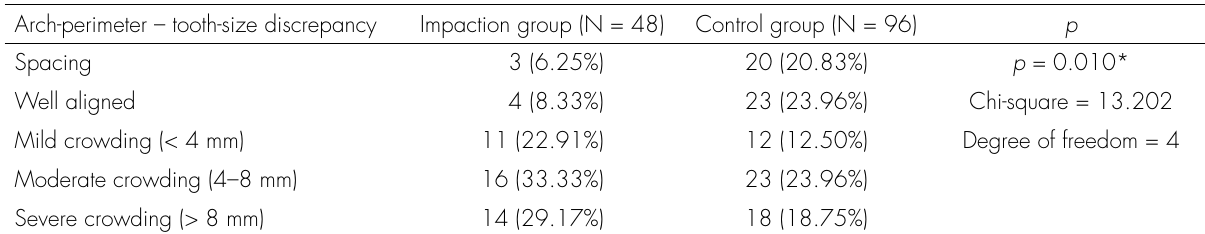
Table III. Number of subjects presenting with or without crowding in the mandibular arch in the impaction and control